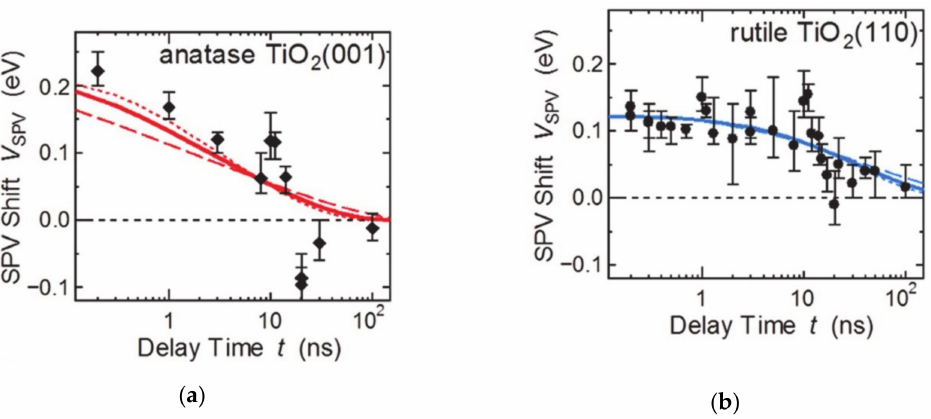
Figure 2. Surface photovoltage analysis for facet-dependent charge carrier relaxation time di ff erence according to the barrier height at the surface. The figure is reproduced from Ref. [44] with permission from the Royal Society of Chemistry.